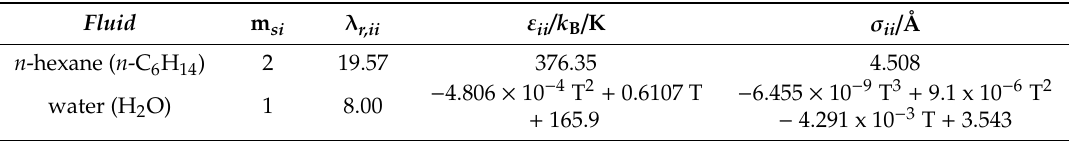
Table 1. Coarse-Grained Mie parameters for pure components a,b,c . Fluid m si